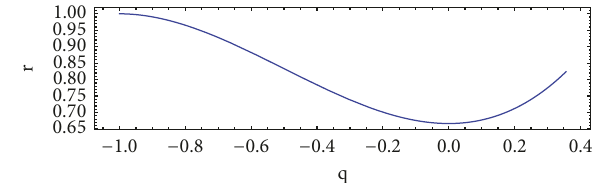
Figure 8: The evolution of the statefinder parameter 𝑟 versus the deceleration parameter 𝑞 for noninteracting GDE in the DGP model. Here, we have taken Ω 𝐷 (𝑧 = 0) = 0.73 , 𝐻(𝑧 = 0) = 67 , and Ω = 𝑟 𝑐